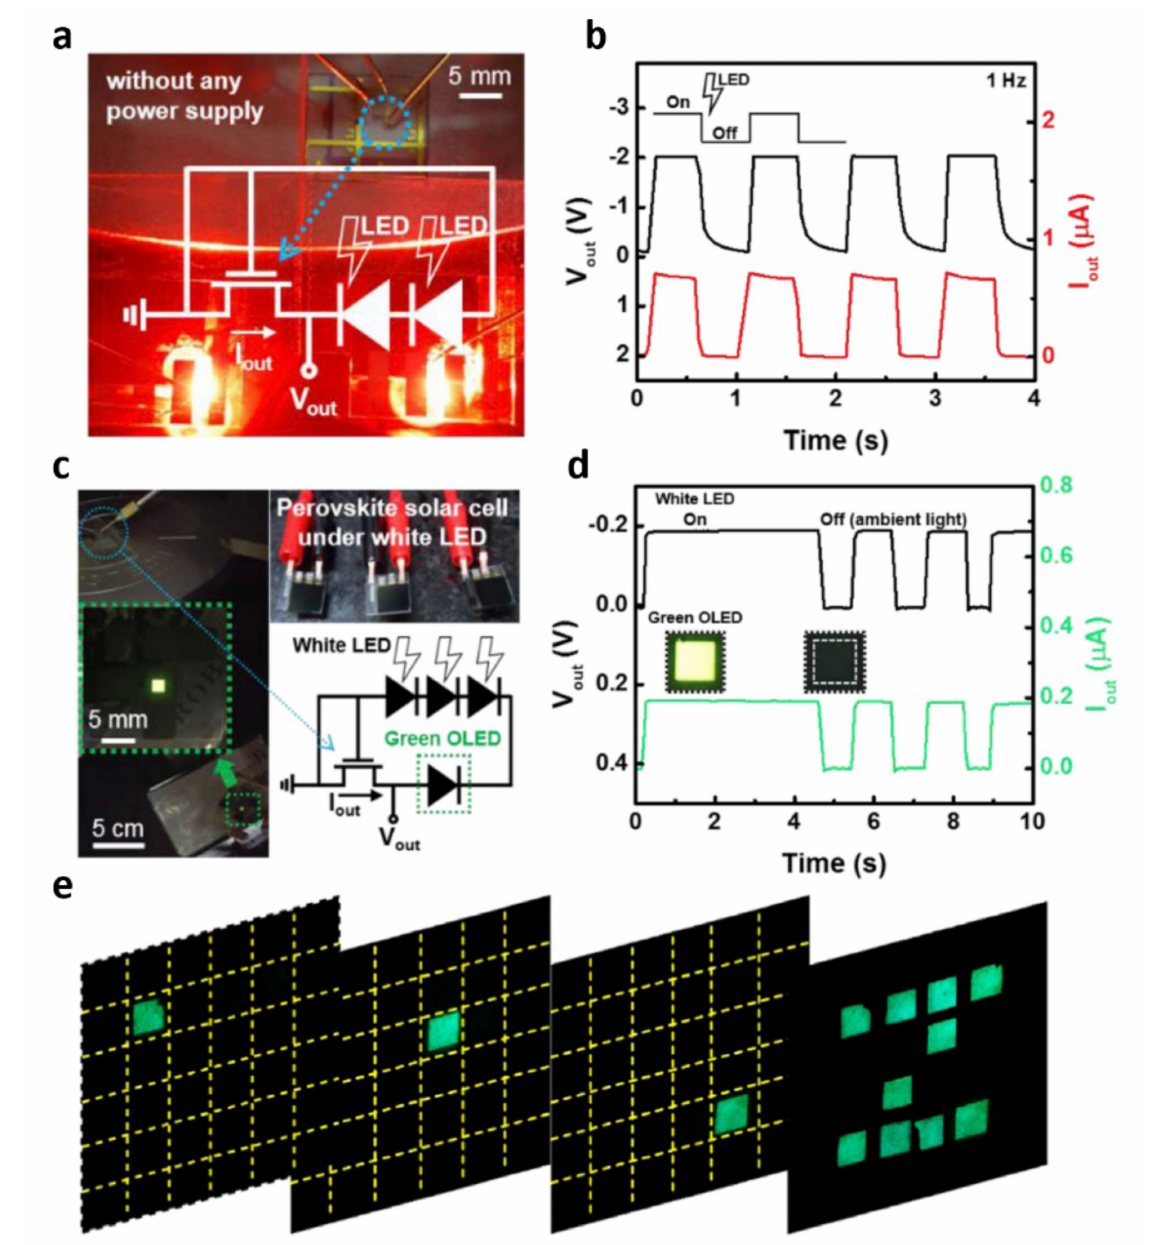
Figure 14. Self-powered integrations: ( a ) optical image of the MoTe 2 transistor and perovskite photovoltaic cells connected in series under red LED illumination, and ( b ) pulsed measurement of an integrated circuit under a red LED pulse at 1 Hz; ( c ) integration of green OLEDs combined with perovskite photovoltaic cells and MoTe 2 switching transistors, and ( d ) pulsed measurement of green OLED under white LED switching. Reproduced with permission from [77], Copyright 2019, Elsevier. ( e ) Pattern array image of MXene-based alternating current electroluminescence integration. Reproduced with permission from [78], Copyright 2021,